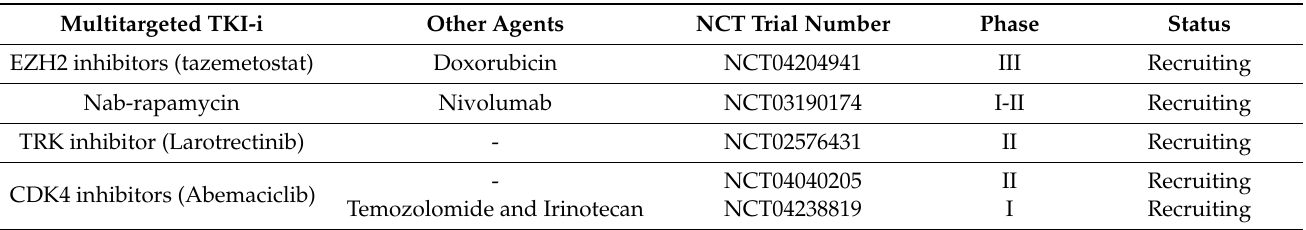
Table 5. Selected multitargeted TKI-i trials in sarcoma a